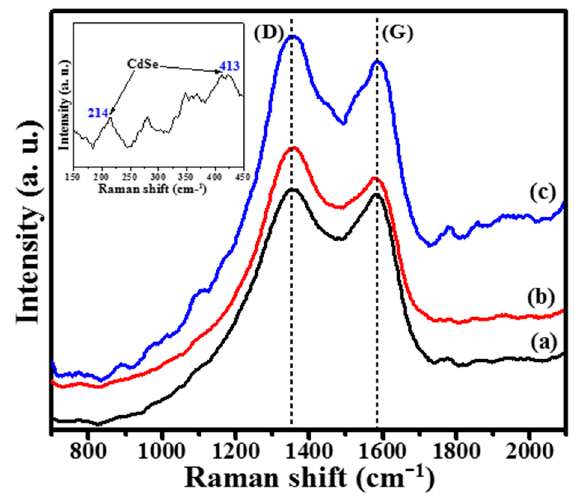
Figure 7. Raman spectra: (a) ECNFs, (b) CdSe@ECNFs, and (c) Co-CdSe@ECNFs. Inset: magnified peaks of CdSe. (D: D band and G: G band).